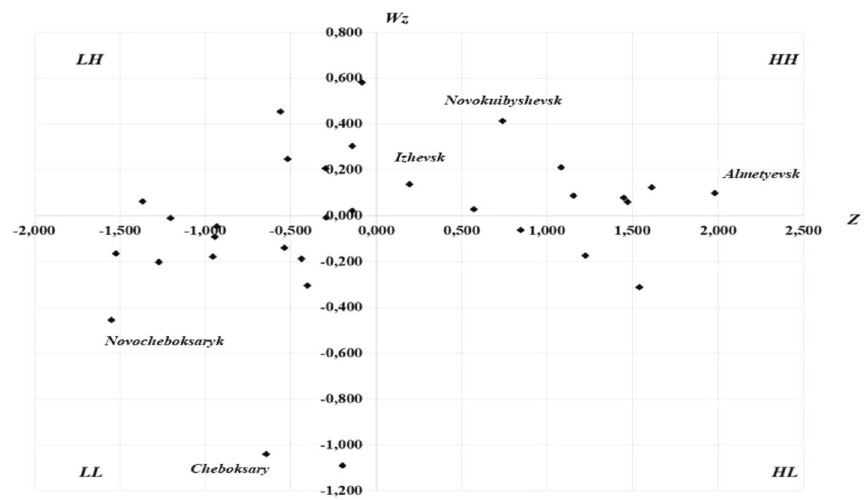
Fig. 5 Moran’s spatial scatter diagram (average monthly salary) for cities of the Volga Federal District of Russia in 2017 (Russian regions. Main social and economic parameters of cities. 2018 // Federal Service of State Statistics [Electronic resource] URL:http:// www. gks. ru/ free_ doc/ doc_ 2018/ region/ reg- gor18. pdf (date of application 07.02.2020).)